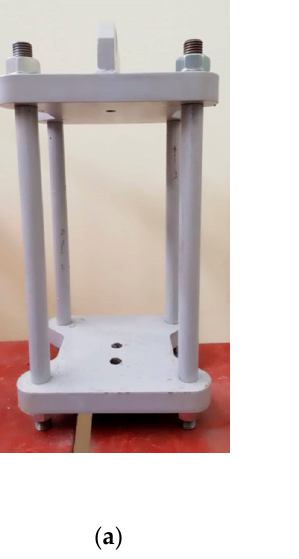
Figure 7. Distribution of bond strength in embedded length—simplification of constant average bond stress.